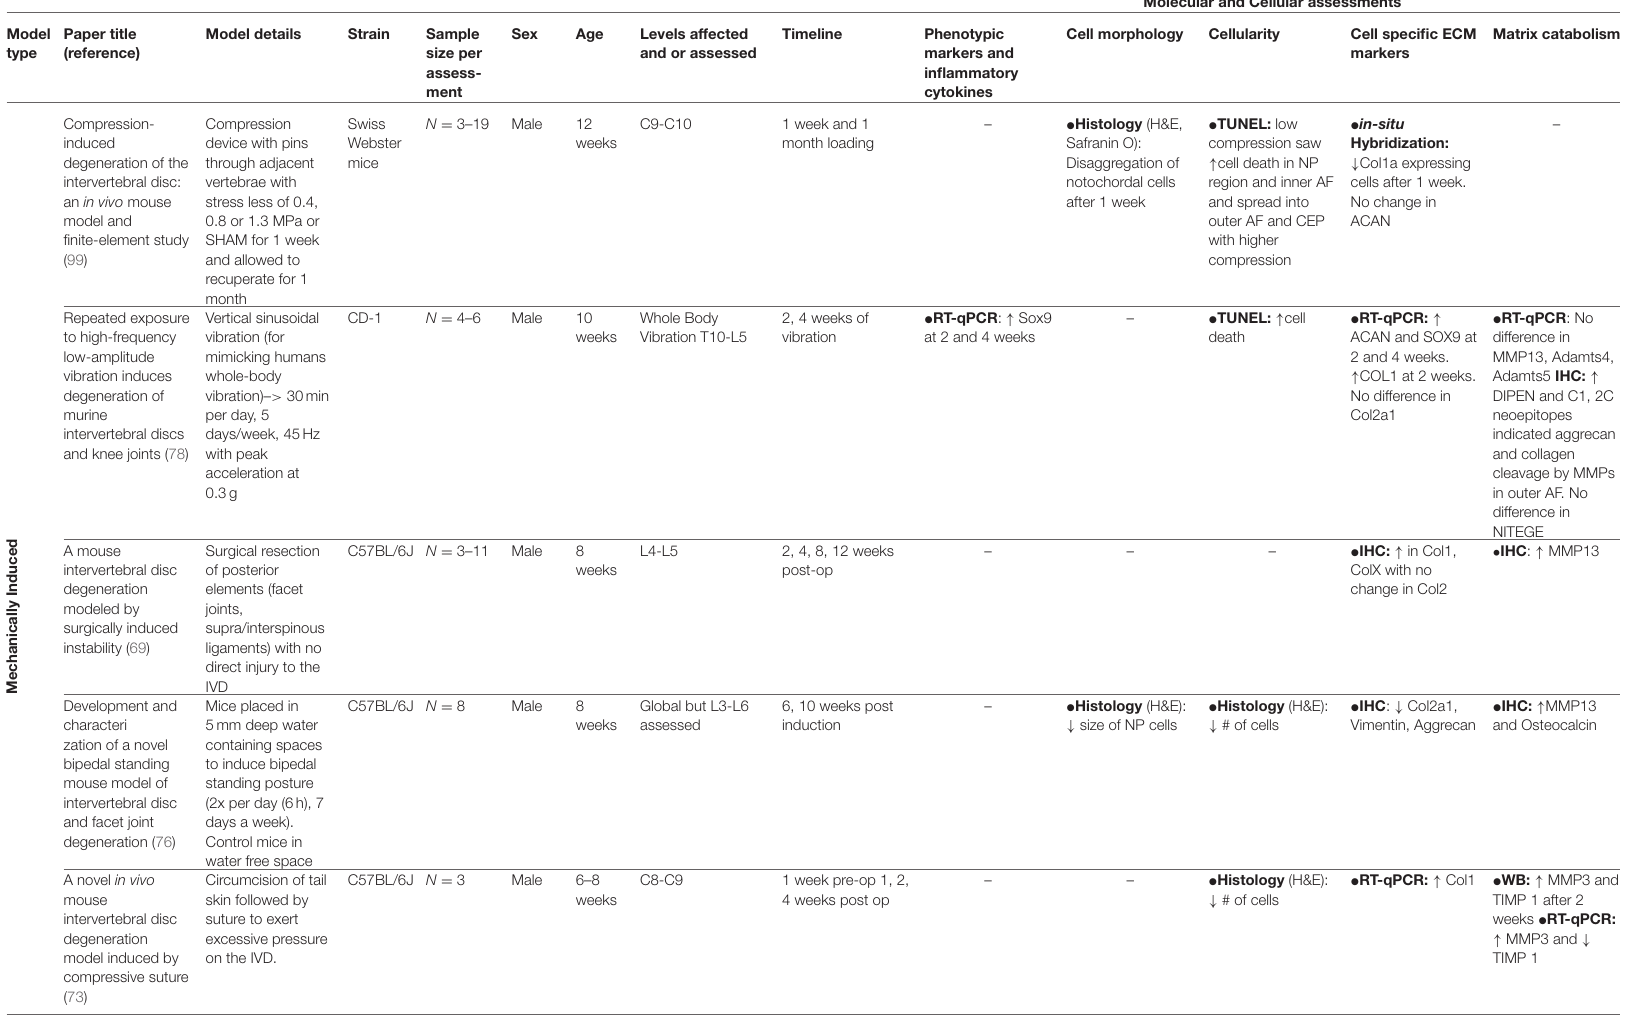
Molecular and Cellular